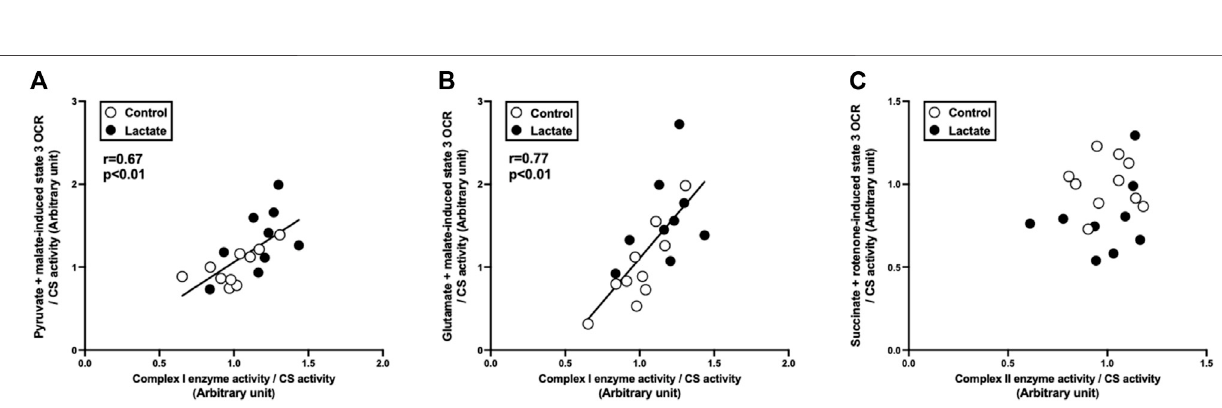
Frontiers in Physiology |